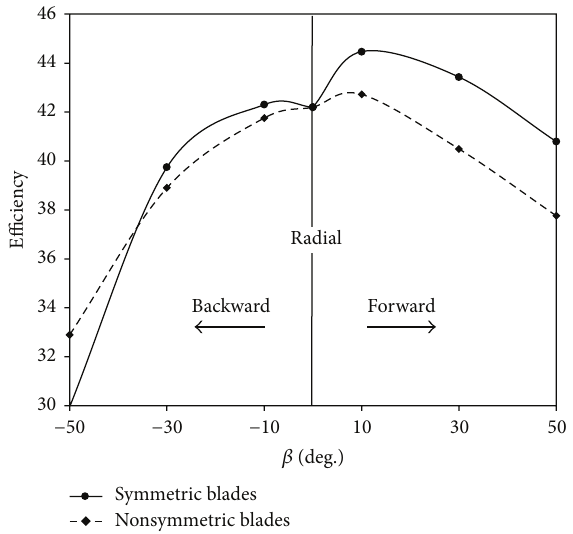
Figure 19: Comparison of efficiency between types of impeller at design flow coefficient.